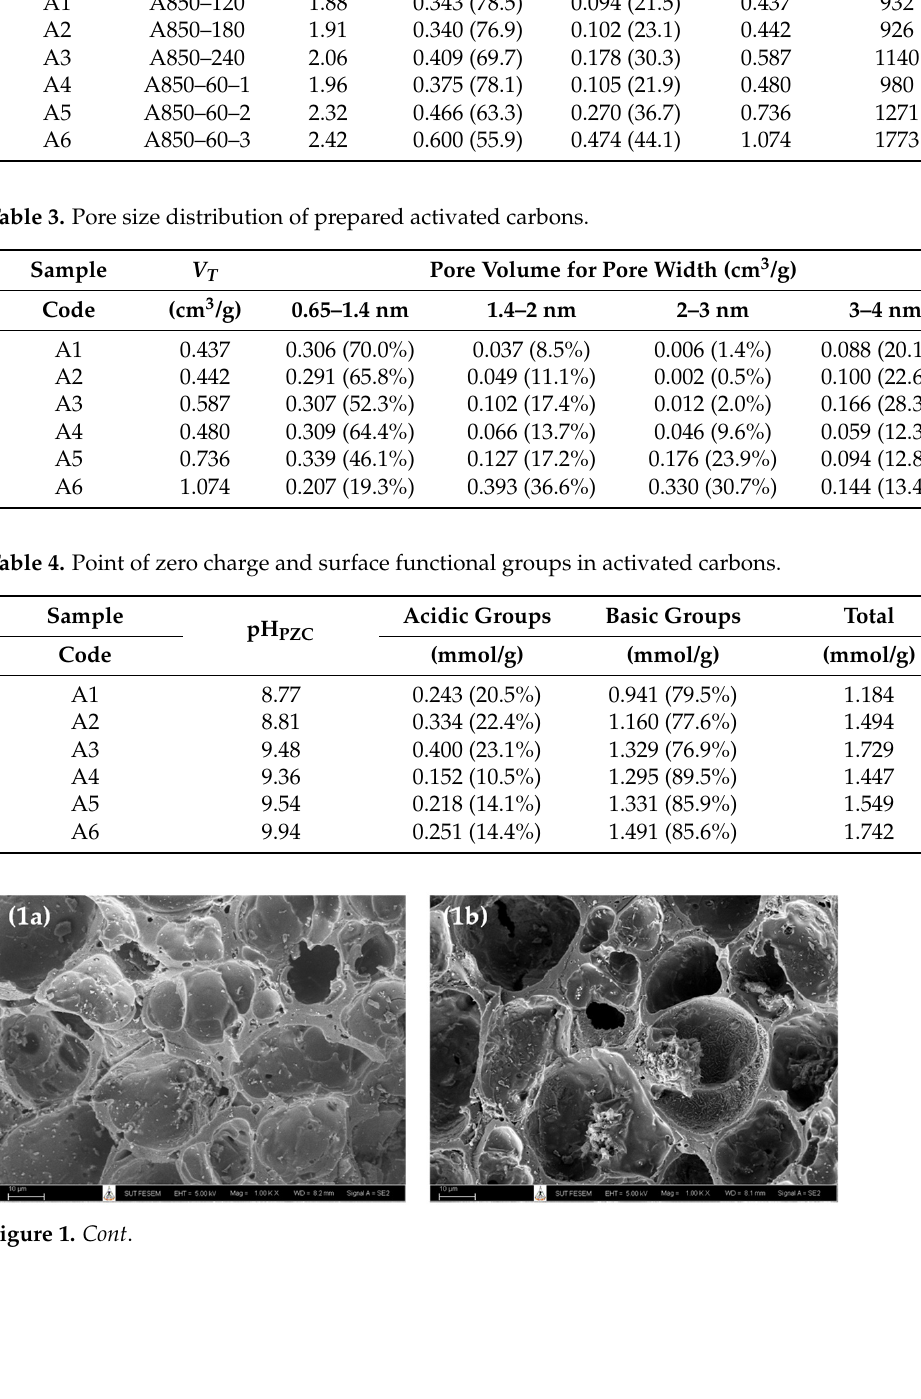
Figure 1. SEM micrographs of ( a ) the microporous-activated carbon of A2 (A850–180), and ( b ) the mesoporous-activated carbon of A5 (A850–60–2), with magnification of 1K for ( 1a – 1b ) and 100 K for ( 2a – 2b ). 3.2. Adsorption Kinetics and Model Testing The kinetic results of MB adsorption by the microporous (A1–A3) and mesoporous carbons (A4–A6) are displayed in Figure 2. The kinetic curves showed a rapid increase of the amounts adsorbed over the first 500 min, followed by a slow increase before attaining an equilibrium at approximately 2000 min. However, the amount of MB adsorbed by the sample A850–60–3 (A6) approached the equilibrium sooner at 1500 min, obviously resulting from its largest average pore diameter (2.42 nm) that allows a faster diffusion rate of dye molecules to the adsorption sites. The amount of dye adsorbed appeared to be higher for the adsorbent with a higher surface area (see Table 2). This indicates that the adsorption sites are distributed more or less uniformly on the carbon surfaces, irrespective of the carbon surface area. In other words, the density of adsorption sites (number per unit area) is approximately constant. The best-fitted model parameters are listed in Table 5. From the values of R 2 and Δ q , it is clear that the experimental kinetic data of MB adsorption by longan seed-activated carbons are best described by the pseudo-second- order model, followed by the pore-diffusion model and the pseudo-first-order model, respectively. The success of the pseudo-second-order model in describing the kinetics of MB adsorption was also reported for activated carbons prepared from various precursors such as abelmoschus esculentus seeds [42], black cumin seeds [43], and lychee seed [44]. Results from Table 5 indicate that the rate constants k 1 and k 2 , as well as the effective pore diffusivity ( D e ), all increased with an increase in the average pore diameter of samples A1 to A3 and A4 to A6. This was anticipated since the larger pore sizes would be able to accommodate the rapid diffusion of relatively large dye molecules. It should also be noted that the pore diffusivities of mesoporous-activated carbons in the range of 4.67 × 10 − 7 –19.92 × 10 − 7 cm 2 /s were larger than those of the microporous carbons (4.66 × 10 − 7 –6.01 × 10 − 7 cm 2 /s) by almost an order of magnitude which should result from higher amounts of mesopores of the former that lower the mass transfer resistance for the transport of dye molecules through the pore network (see Table 2). The molecular diffusivity of methylene blue in water at 35 °C, as estimated by the Wilke–Chang equation [45], is about 5.57 × 10 − 6 cm 2 /s, which is about ten times and six times larger than the average pore diffusivities of the microporous carbon and mesoporous carbon, respectively. This suggests that the process of MB adsorption is controlled by the intra-particle diffusion of MB molecules,